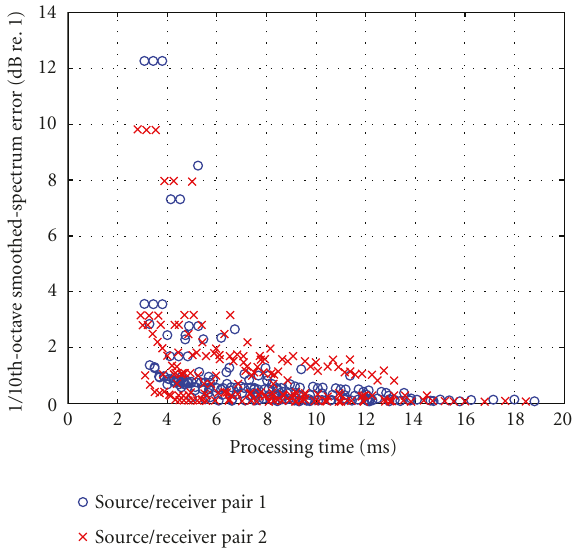
Figure 5: Maximum error in the 1/10th-octave smoothed spectra below 20kHz for various alignment-zone sizes (1 to 10 samples), segment sizes (40, 100, or 300 samples), and integration techniques (1-point, 3-point, or 5-point) using the hybrid